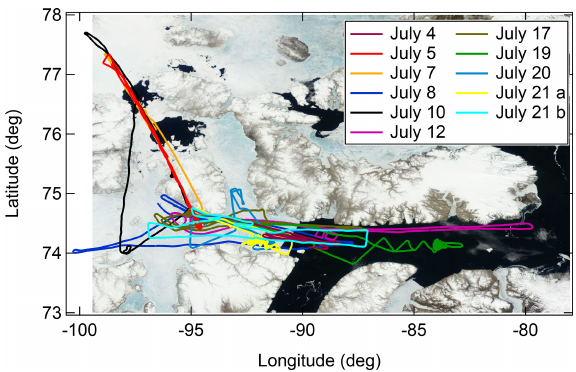
Figure 1. Satellite image (visible range from MODIS) from 4 July 2014 with a compilation of flight tracks conducted during 4–21 July 2014 (indicated with different colours). On 21 July 2014, two flights were performed, indicated by a and b in the